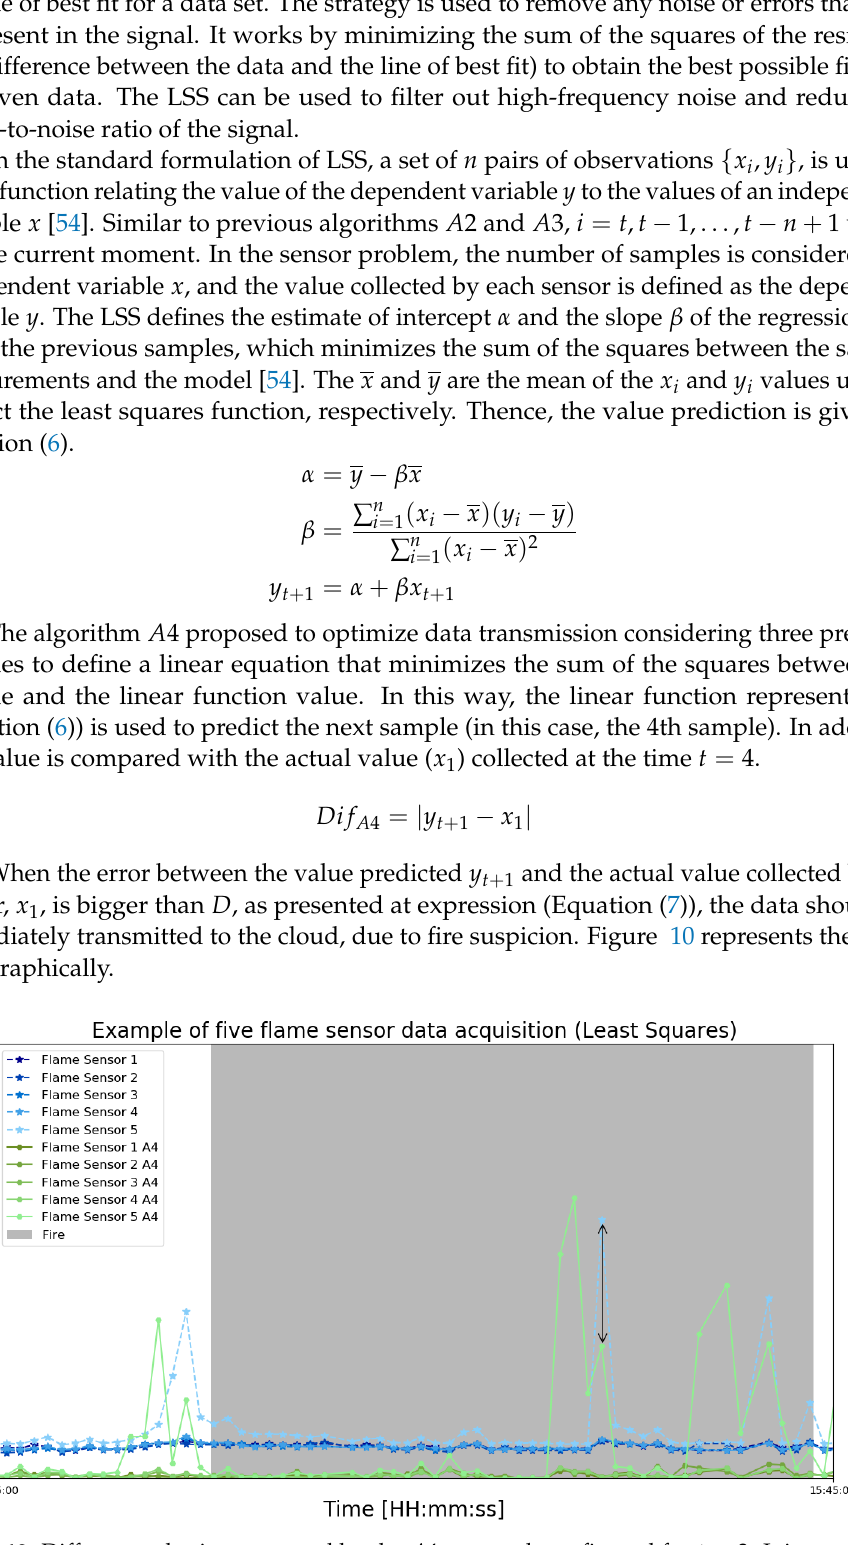
Figure 10. Difference plotting proposed by the A 4 approach configured for t = 3. It is possible to visualize the difference between raw and predicted data